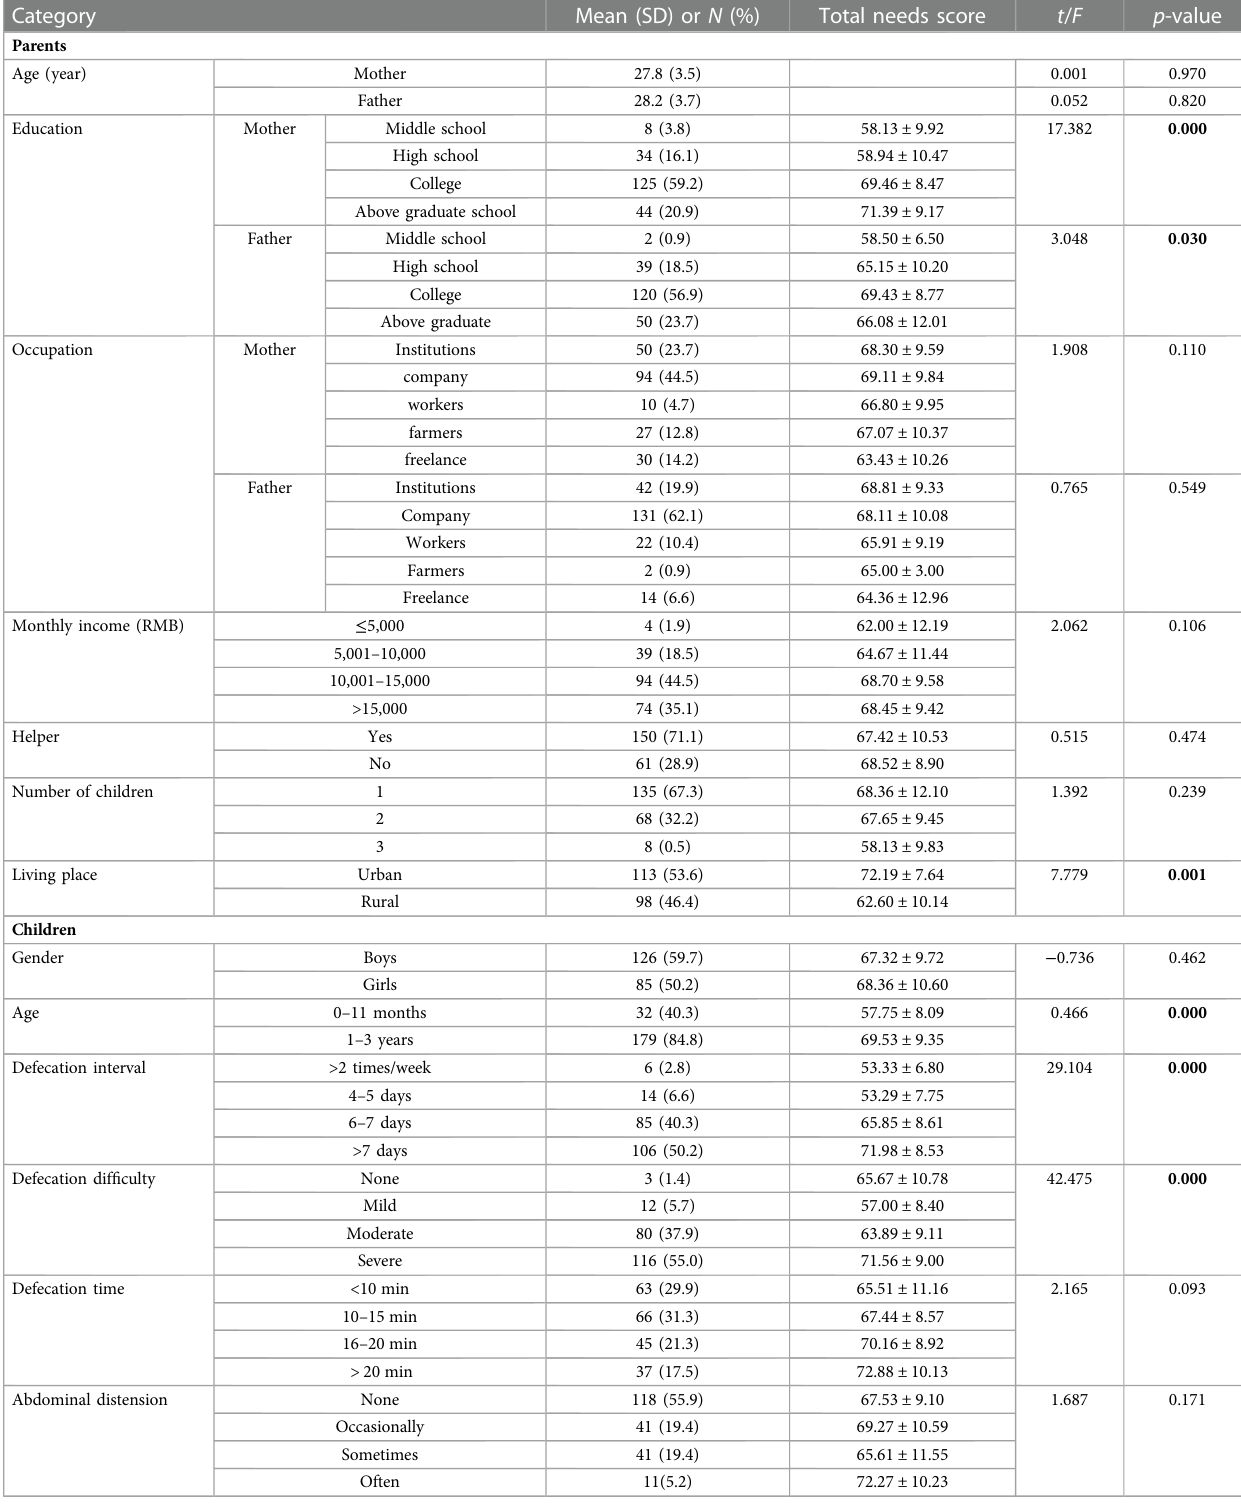
TABLE 2 Demographic information and single-factor analysis in nursing needs ( N =211).